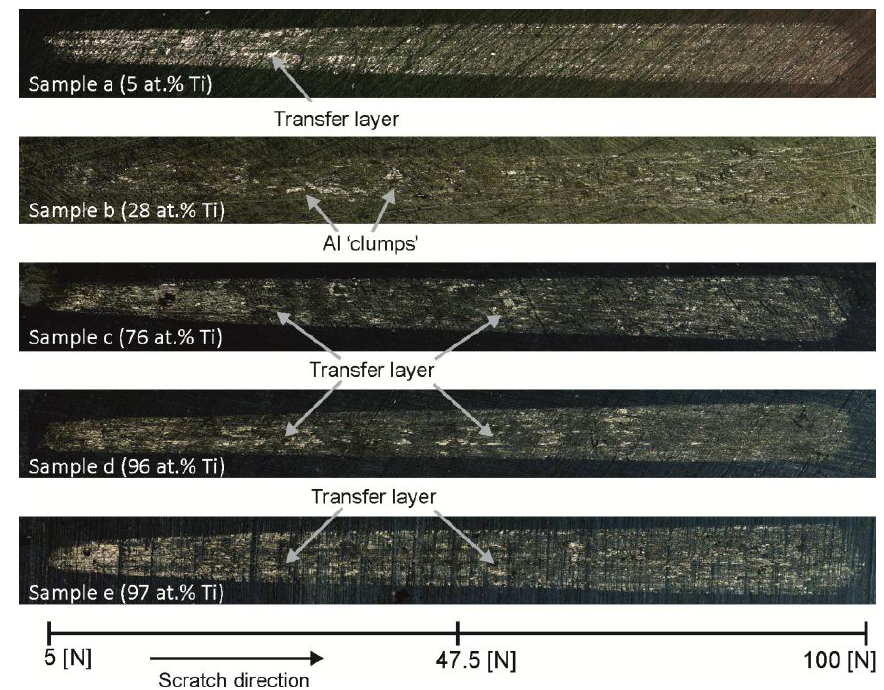
Figure 8. Optical microscope images of scratches after ball on flat frictional test with an Al ball, for progressive increasing load 5–100 N.